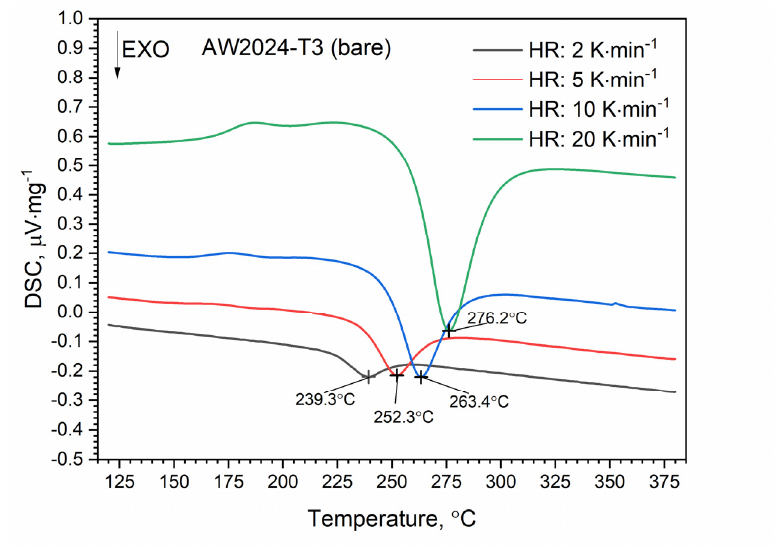
Figure 9. DSC thermograms of bare AW-2024-T3 at various heating rates (HRs).